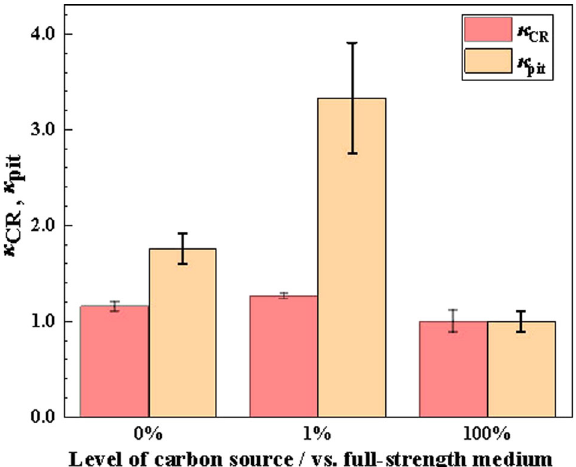
Fig. 8 κ CR and κ pit for BM zone. The fi gure shows κ CR and κ pit of organic carbon source starvation on corrosion of BM for the welded joints (error bars stand for the standard deviations from three independent sample).